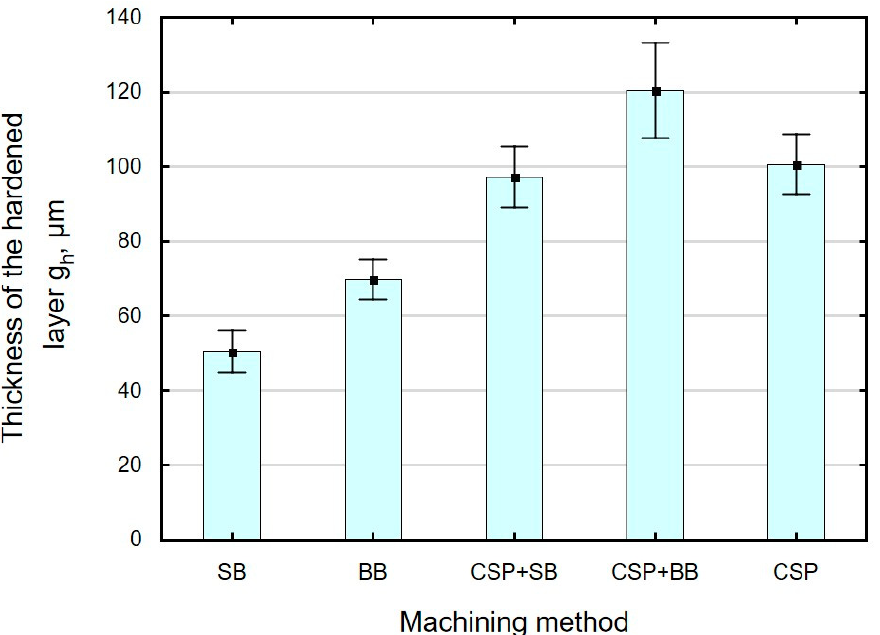
Figure 12. Finishing method versus hardened layer thickness g h (SB—slide burnishing, BB—ball burnishing, CSP + SB—centrifugal shot peening + slide burnishing, CSP + BB—centrifugal shot peening + ball burnishing, CSP– centrifugal shot peening).